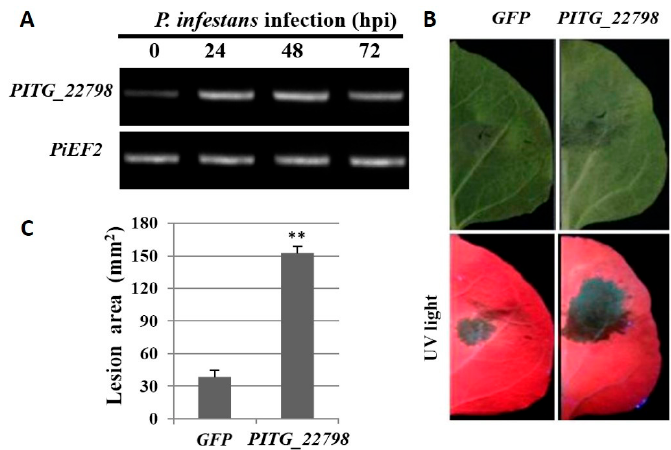
Figure 1. PITG_22798 is induced during infection of P. infestans and promotes colonization. ( A ) Semiquantitative RT-PCR was performed to test PITG_22798 expression during P. infestans infection in potato leaves at 0, 24, 48, 72 hours post-inoculation (hpi). The elongation factor 2 gene ( PiEF2 ) of P. infestans was used as a control to equalize cDNA amounts. ( B ) A typical leaf with larger lesions on the half of the leaf expressing PITG_22798 in N. benthamiana . Agrobacterium was used to transiently express PITG_22798 on one half of a leaf and GFP (Green Fluorescent Protein) on the other. Leaves were subsequently infected with P. infestans . The pictures were taken at 5 days after inoculation under white light ( top ) and UV light ( bottom ). The OD600 of Agrobacterium for transient express of PITG_22798 is 0.05. ( C ) Lesion area at 5 d after zoospore inoculation following infection of GFP - or PITG_22798 -expressing leaf tissue with P. infestans 88069. Results are the mean ± SE of infections from three biological replicates using at least nine leaves each. The asterisk indicates a value significantly different from the GFP ( p < 0.01, t -test).